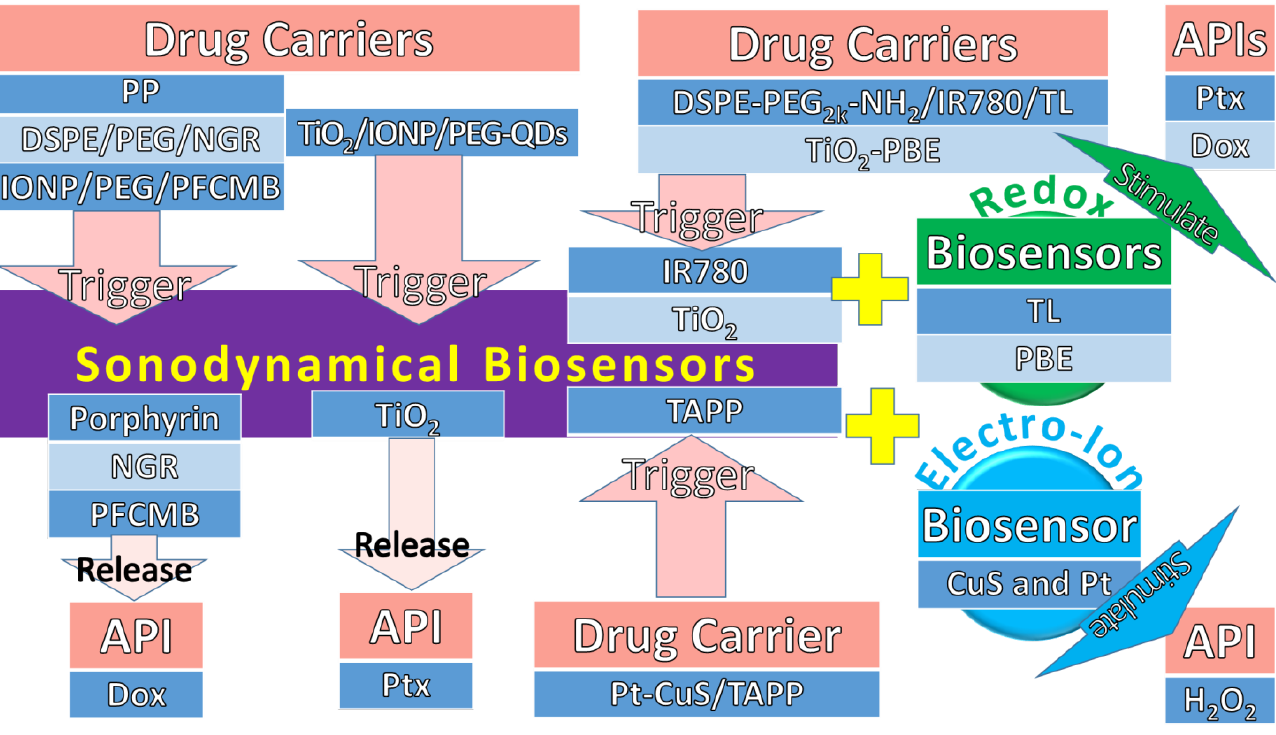
Figure 5. The sonodynamical trigger with either redox or electro-ion stimuli added into their biosensors in drug carriers to release API. The flows from drug carriers to API are represented by the first and third cells, and second cells, as shown in dark blue and light blue, respectively.